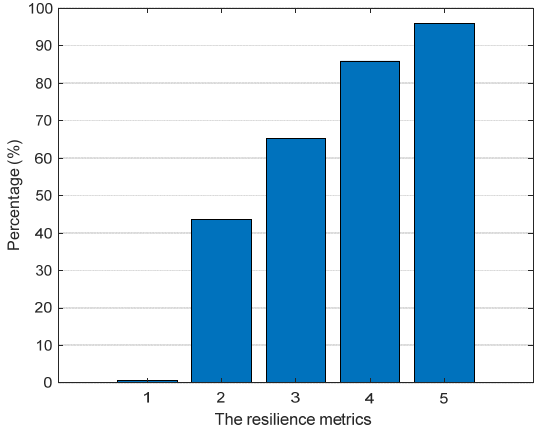
Figure 7. Obtained Pareto-optimal front for the IEEE 118-bus test system. Note: By increasing vulnerability function, resiliency is deteriorated.